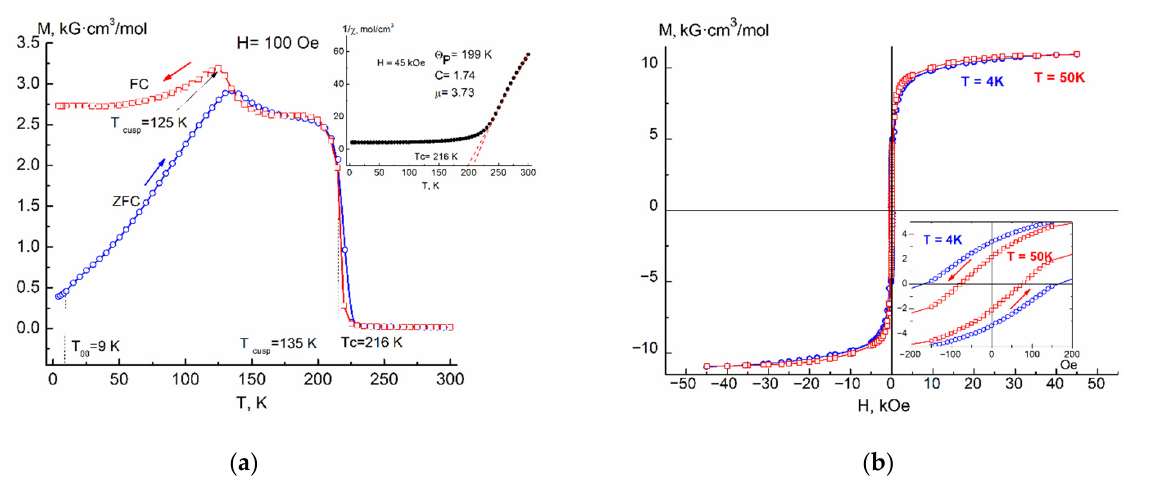
Figure 4. ( a ) Dependences of the M vs. Т of FC and ZFC magnetization for Fe 0.80 Ag 0.20 Cr 2 S 4 in a 100 Oe field. Inset: dependence of the inverse magnetic susceptibility versus temperature for this composition. ( b ) Field dependences of the magnetization for Fe 0.80 Ag 0.20 Cr 2 S 4 at 4 and 150 K. Table 1. Magnetic parameters of Fe 1 − x Ag x Cr 2 S 4 solid solutions.